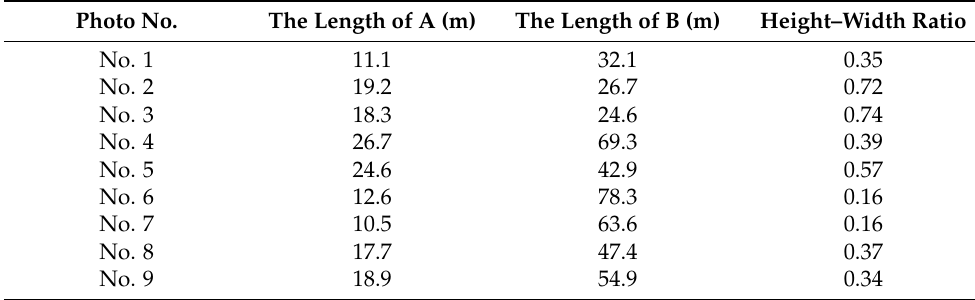
Table 3. The statistics of the window–wall ratio of the Chinese courthouse buildings. Photo